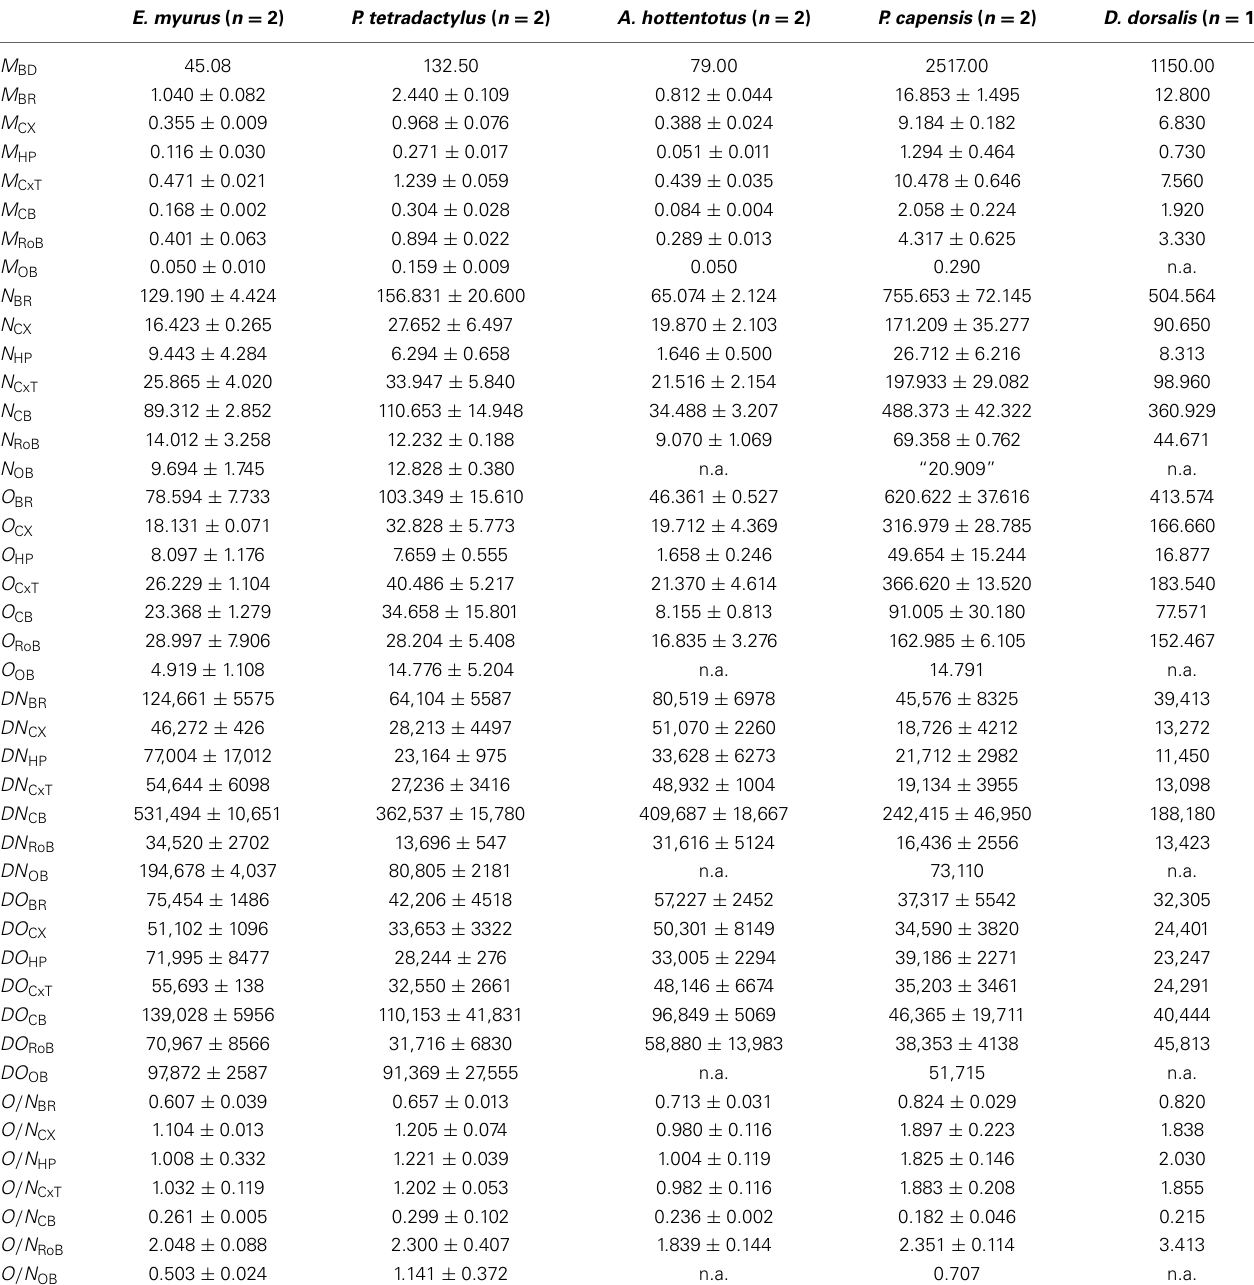
Table 1 | Cellular composition of afrotherian